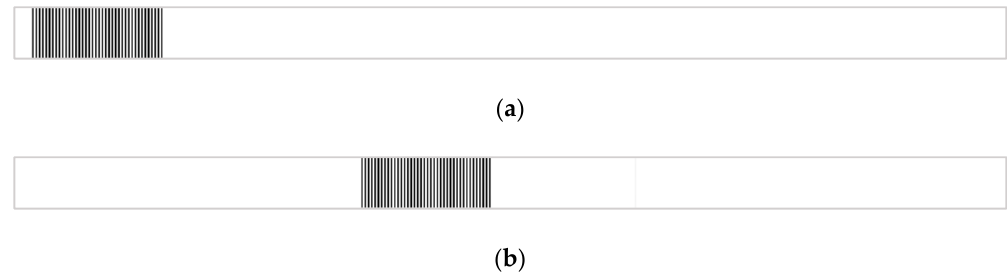
Figure 5. One ‐ dimensional images for phase correlation calculation. ( a ) Reference image; ( b ) Shifted Figure 5. One-dimensionalimagesforphasecorrelationcalculation. ( a )Referenceimage; ( b image .